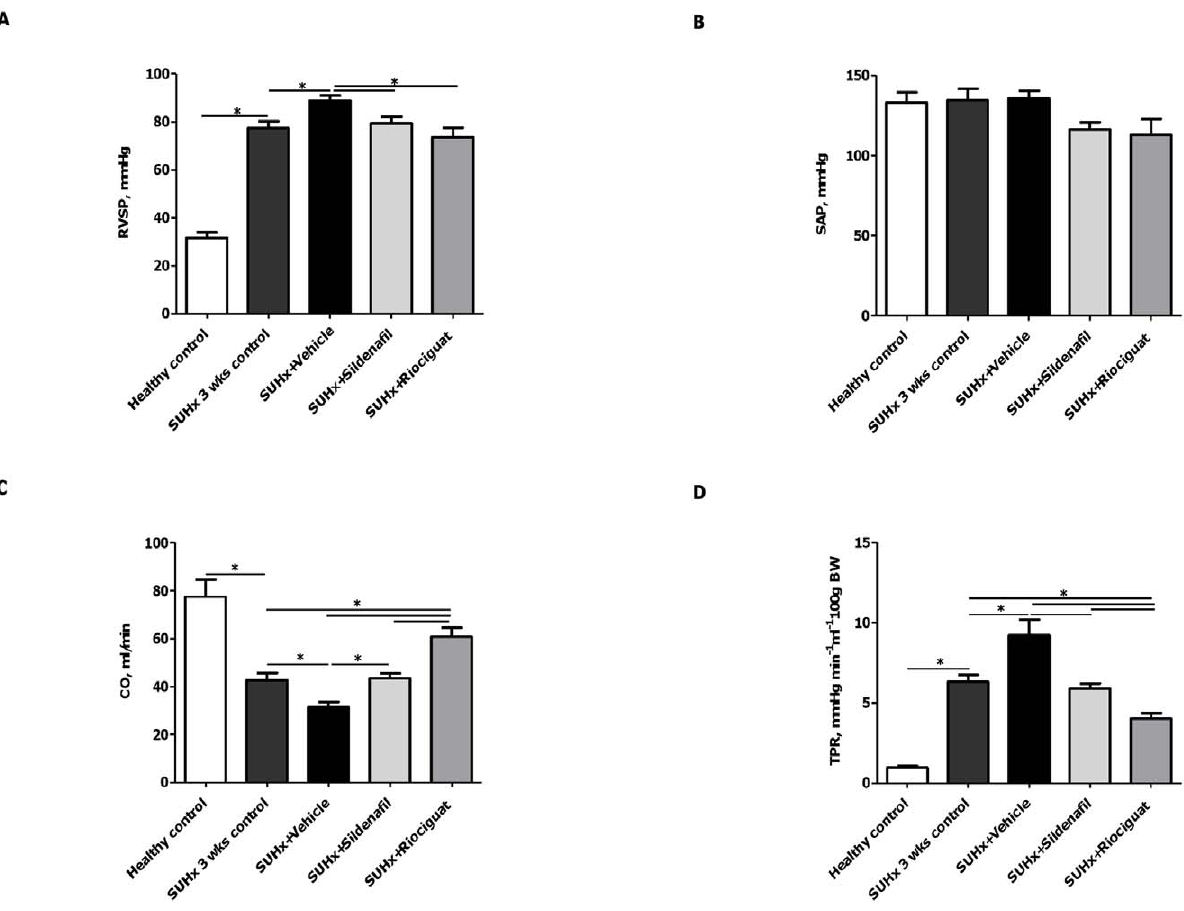
Figure 1. Effects of riociguat and sildenafil on hemodynamics in SUHx rats. (A) RVSP, (B) SAP, (C) CO and (D) TPR of different treatment groups. * p , 0.05. Note . CO, cardiac output; RVSP, right ventricular systolic pressure; SAP, systemic arterial pressure; TPR, total pulmonary